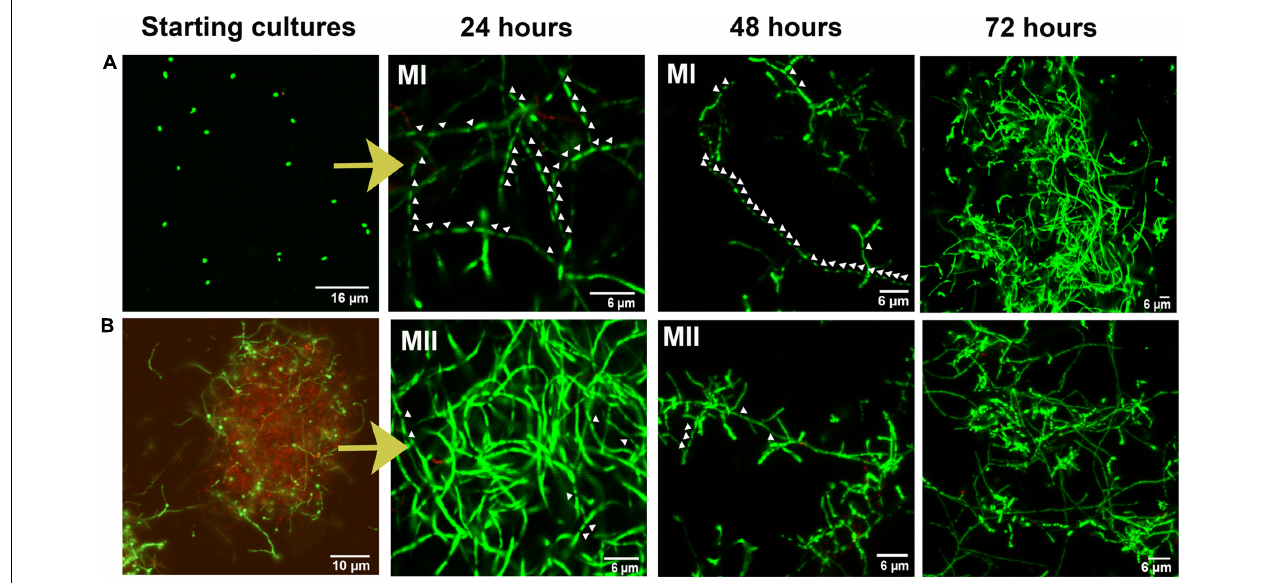
FIGURE 3 | Confocal laser-scanning fluorescence microscopy analysis (SYTO9/PI staining) of Streptomyces albus -pAPI development in liquid cultures under two different conditions. (A) morphology of control cultures inoculated with a spore preinoculum. (B) Morphology of conditioned cultures inoculated with a high-density pre-grown culture in which programed cell death processes was induced. Arrows indicate mycelium septa. MI: type I mycelium (compartmentalized mycelium); MII: type II mycelium (multinucleated mycelium, secondary metabolite